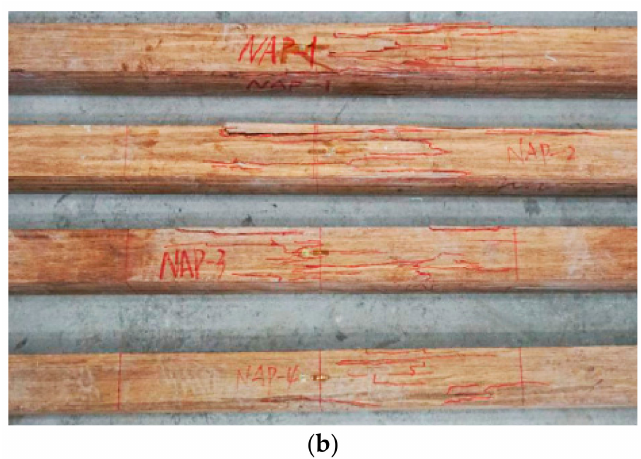
Figure 3. This is the failure photos for parallel bamboo strand lumber (PBSL) beams: ( a ) is the side surfaces; ( b ) is the bottom surface.